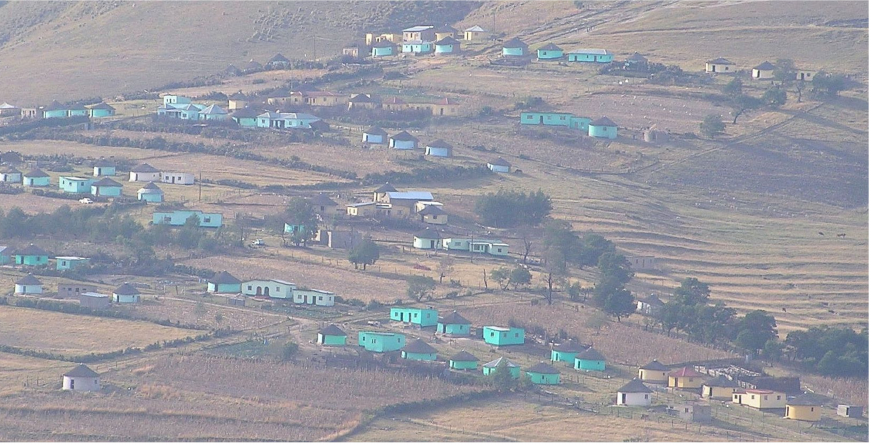
Figure 5. Photograph of a “Betterment Scheme” settlement known as Brook’s Nek, on communal land in the former Transkei area of the Eastern Cape Province